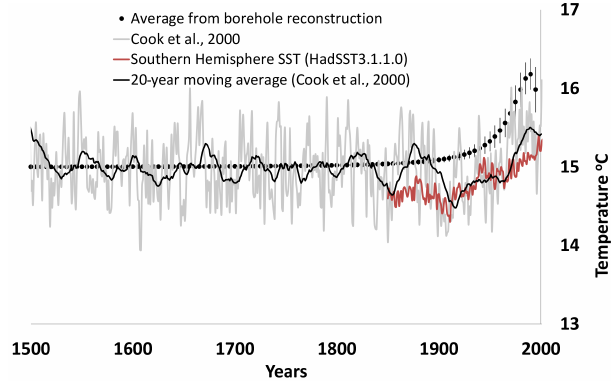
Figure 11. Comparison of temperature histories reconstructed us- ing borehole data with those from Tasmanian dendroclimatological reconstruction and Southern Hemisphere sea surface temperature